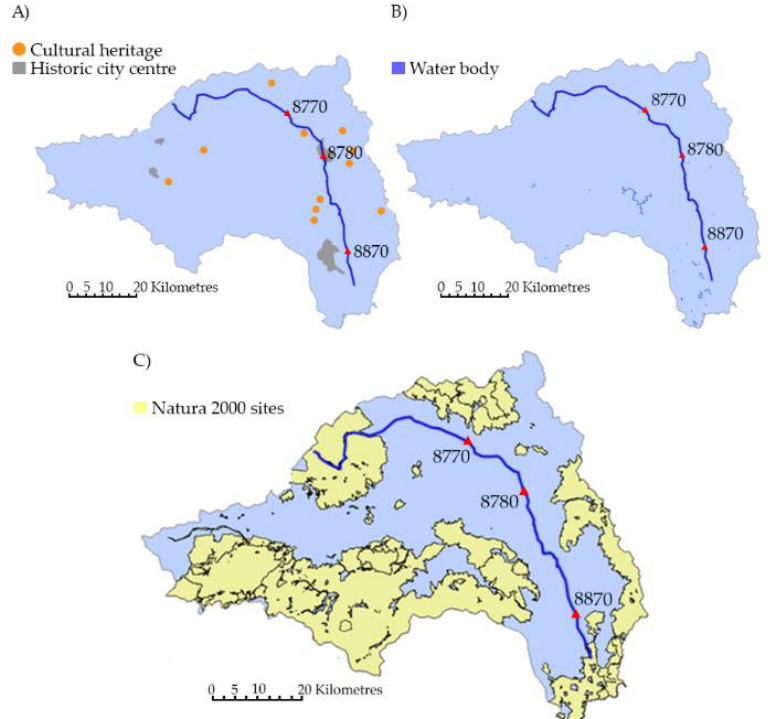
Figure 9. Summary of possible geographical collisions with localities unsuitable for small hydro- electricity power plants (( A )—Locations of the cultural heritage sites, ( B )—Locations of other water bodies, ( C )—Locations of NATURA 2000 protected areas).